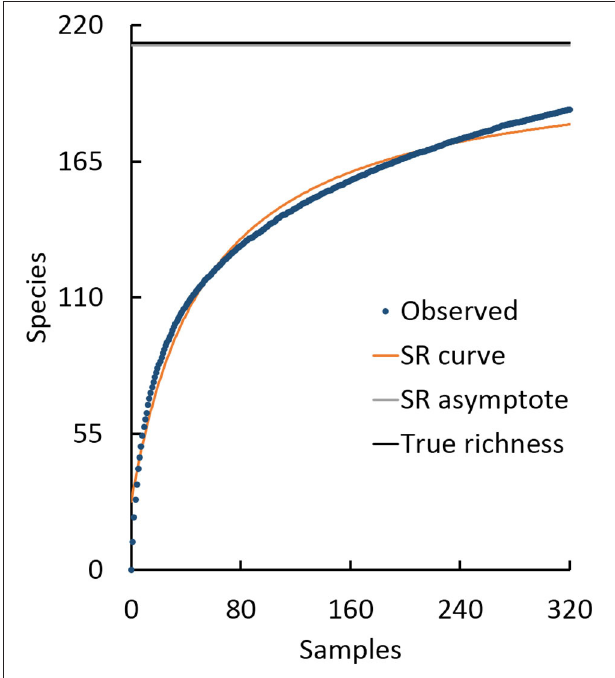
FIGURE 4 | Accumulation curve for spider sampling in Gerês (Portugal). The result of searching for the best fitting asymptotic formula using symbolic regression is also